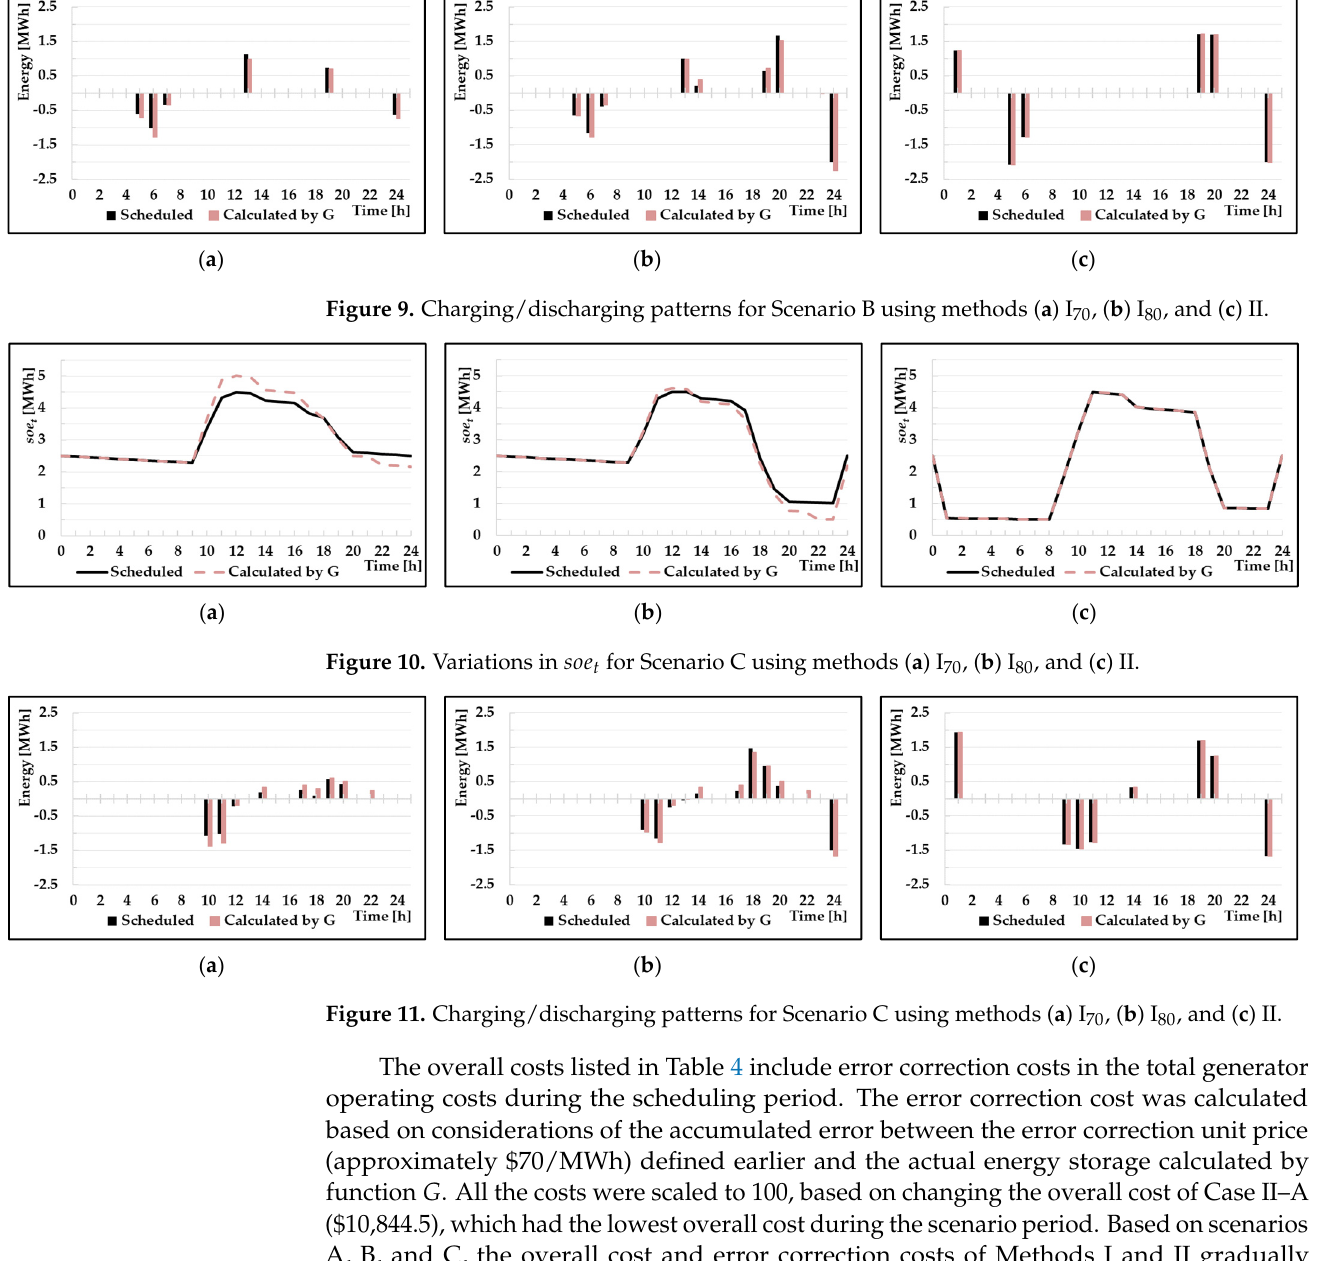
Figure 8. Variations of